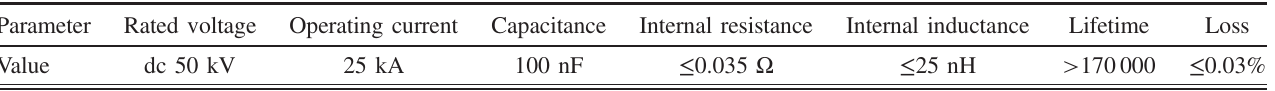
TABLE IV. Parameters of repetitive operation and the long-life high voltage pulse